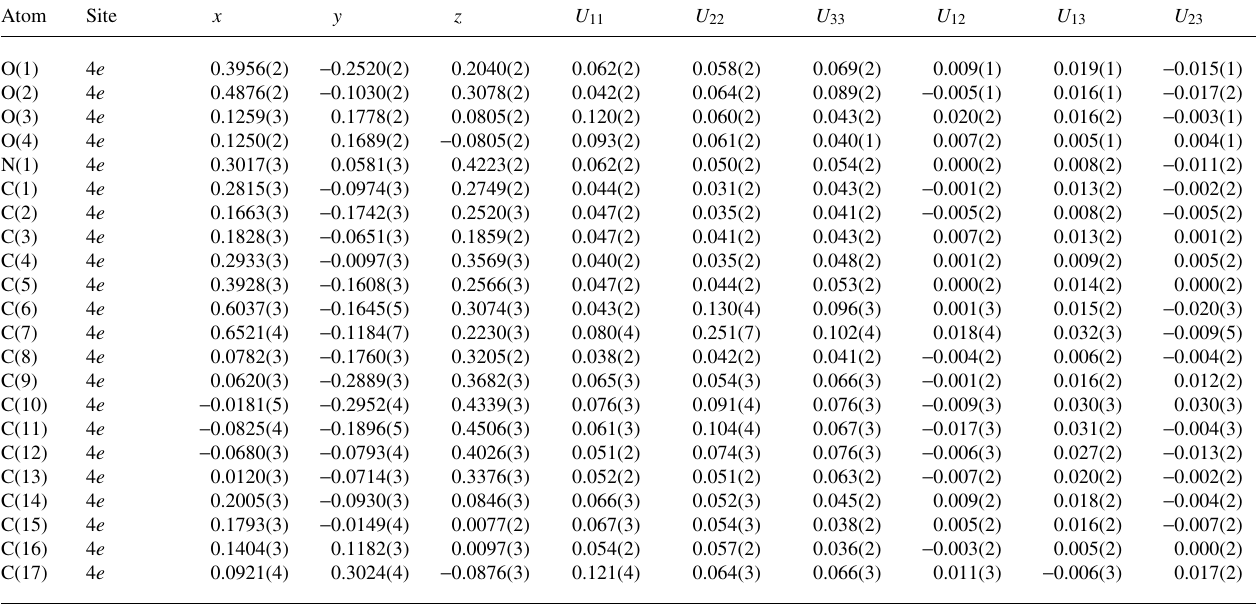
Table 3. Atomic coordinates and displacement parameters (in Å 2 )